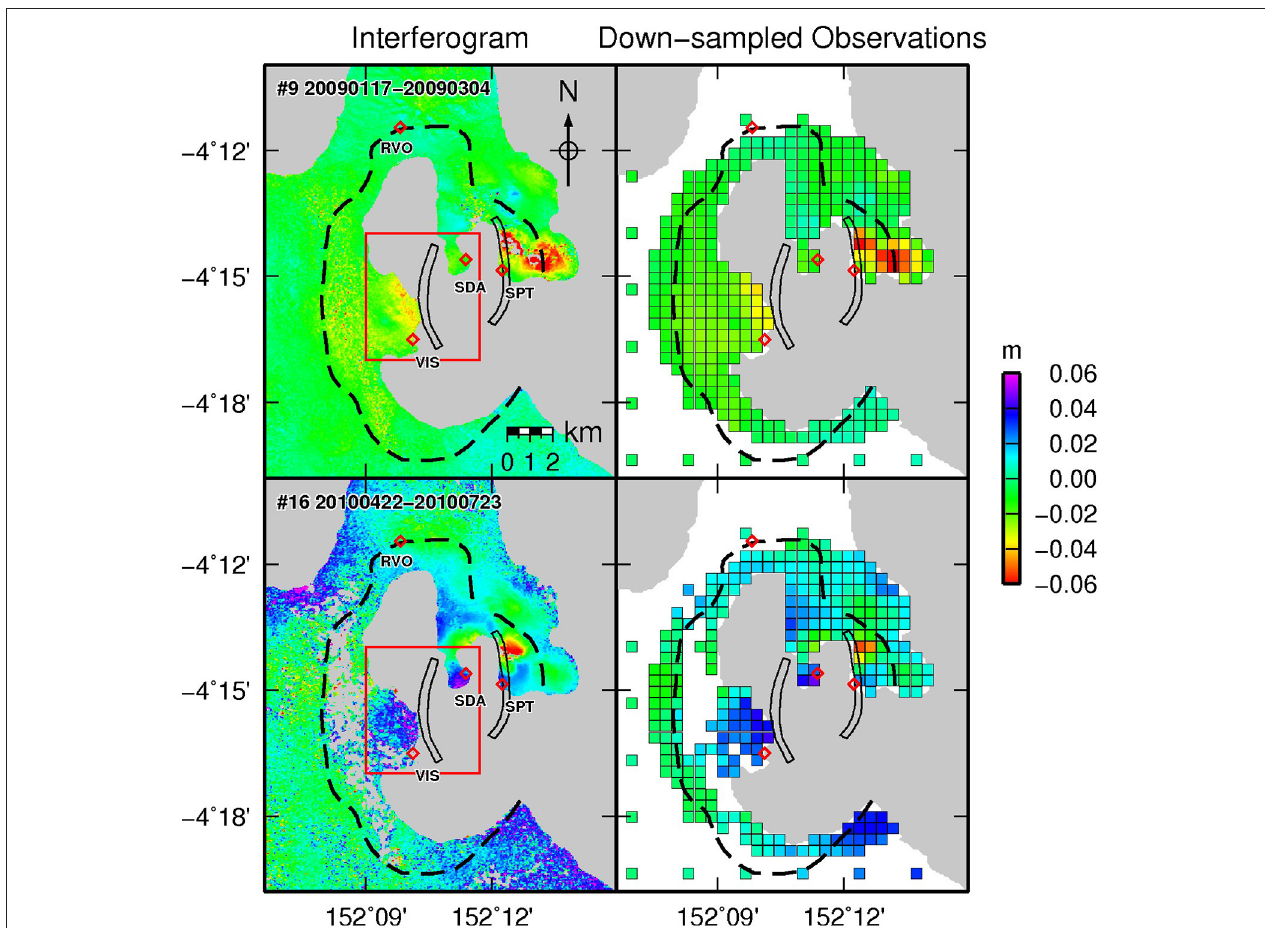
FIGURE 5 | Examples of unwrapped geocoded ALOS-PALSAR interferograms and the corresponding down-sampled InSAR observations used for modelling. Interferogram #9 corresponds to the time of caldera subsidence (negative signal), whilst interferogram #16 corresponds to the time of caldera uplift (positive signal). Both interferograms contain large spatially-correlated signals not directly related to the deformation of the shallow magma body. Red labelled diamonds indicate the location of the four GNSS stations. All 20 interferograms and down-sampled InSAR observations are shown in Supplementary Figure 1 . Black dashed line indicates the general topographic rim of the nested caldera complex and the black polygons outline the two zones of concentrated seismicity (Figure 2) . The red-outlined square encloses the areas where deformation signals attributed to the shallow caldera magma body are